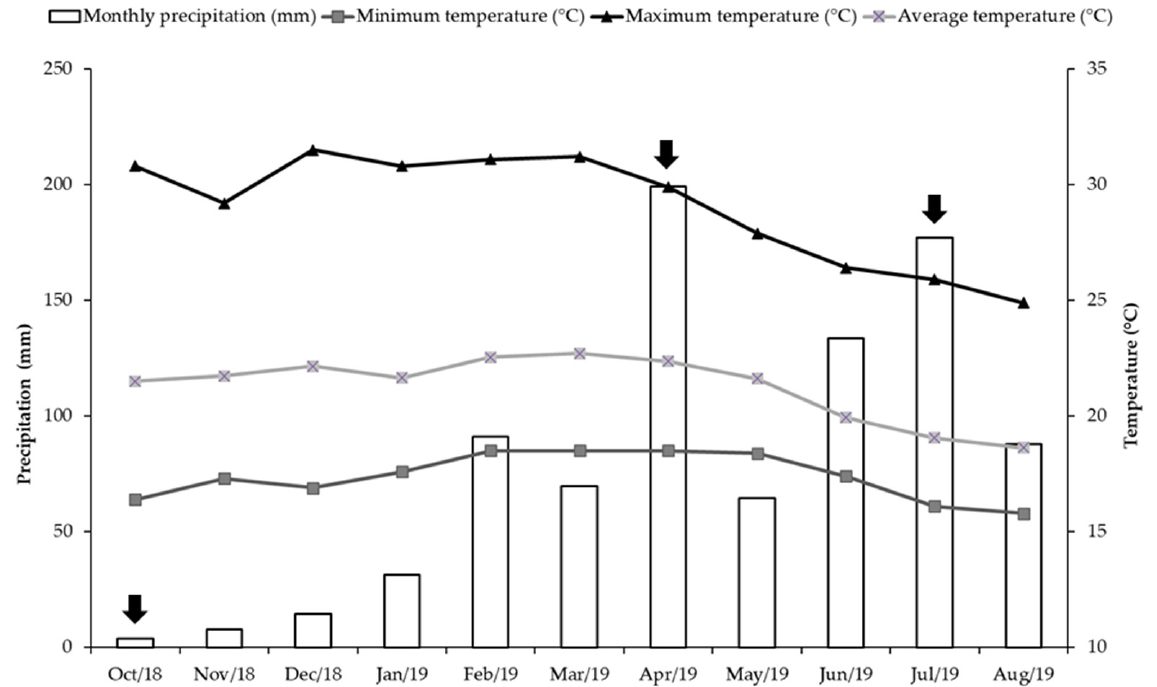
Figure 1. Monthly rainfall and temperatures (maximum, average, and minimum) at Caruaru Experimental Station (IPA) during the experimental period. Arrows indicate sampling dates. Source: Instituto Agronômico de Pernambuco-IPA, Brazil. The experiment was installed in March 2011, when the area was covered with typ- ical Caatinga vegetation, a dry forest native to the region. Tree legumes were planted in three double rows per plot, spaced 9 × 1 × 0.5 m, with IPA-Sert â nia cactus planted between the double rows and in monoculture, at a spacing of 1 × 0.25 m [19]. In the agro- forestry plots, the density of tree legumes was 4000 plants/ha, and the cactus density was 32,000 plants/ha. In monoculture, the cactus density was 40,000 plants/ha. In June 2018, the experimental area was fertilized with cattle manure (O.M. = 412 g kg − 1 ; N = 15 g kg − 1